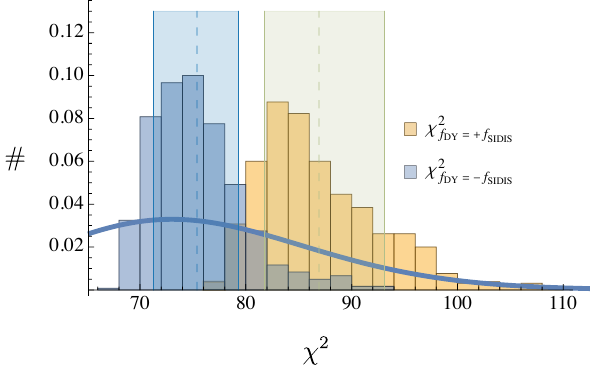
= + f ⊥ (yellow) and 1 T [ DY ] 1 T [ SIDIS ]